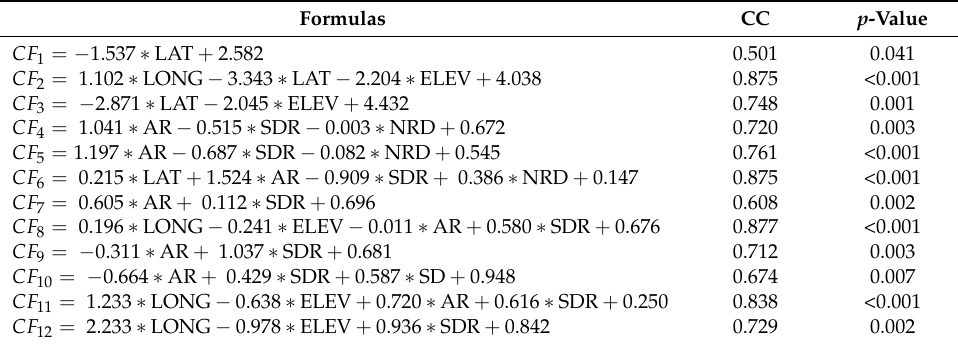
Table 8. Multiple linear models to predict correction factors of TMPA 3B42RT data.